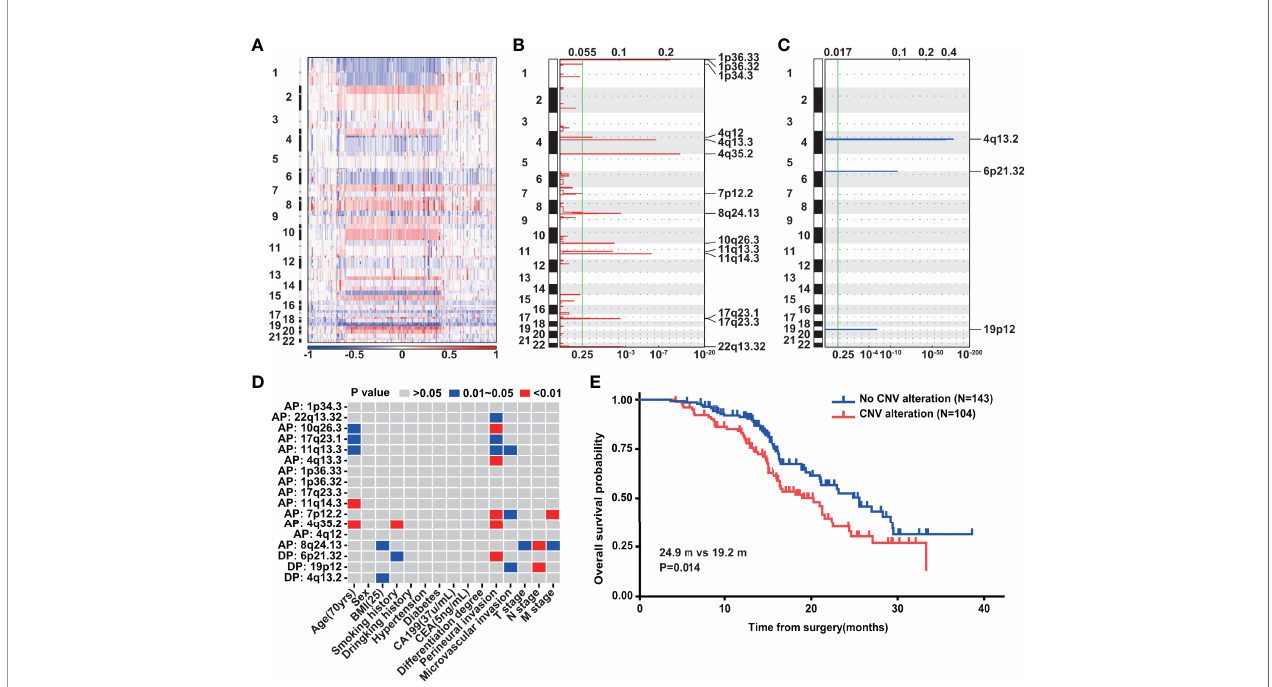
FIGURE 5 | Copy number variation of PDAC. (A) The landscape of CNV in PDAC (n = 302). (B) Gains of CNV in PDAC (n = 302). G-score at top and q-value at bottom. (C) Losses of CNV in PDAC (n = 302). G-score at top and q-value at bottom. (D) The correlation between CNVs and clinical variables in PDAC (n = 302). (E) Overall survival analysis of above 247 PDAC patients with (n = 104) and without (n = 143) the 17 signi fi cant chromatin structure